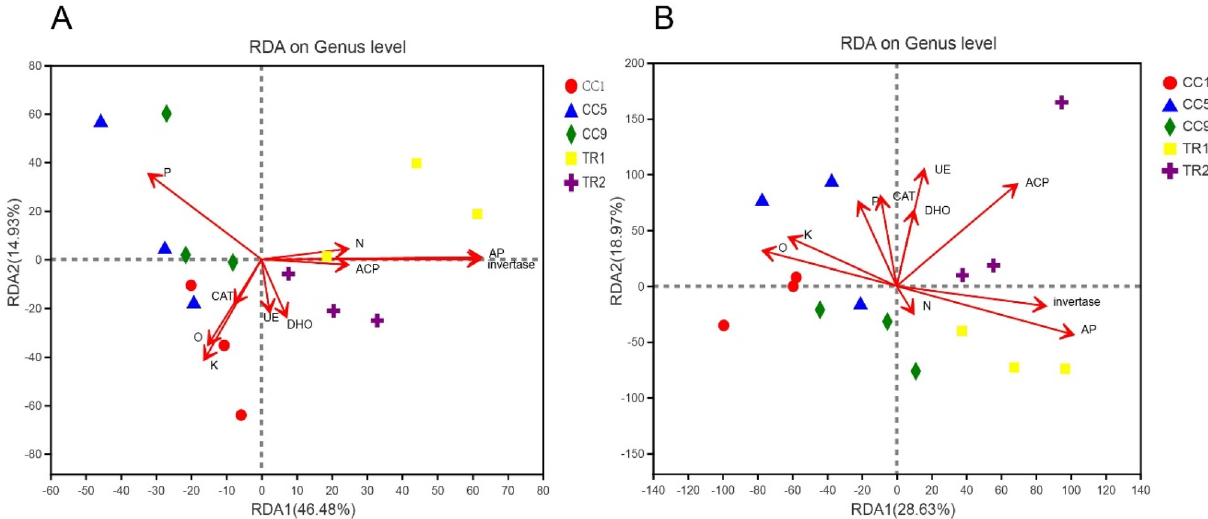
Figure 6. Compositions of pepper soil bacterial ( A ) and fungal ( B ) communities, and analyses of soil physical and chemical characteristics and enzyme activities using Redundancy Analysis (RDA), which can reflect the samples and environmental factors on the same two-dimensional ranking graph, so as to intuitively see the relationship between sample distribution and environmental factors). The RDA mapping data came from soil samples of the five continuous pepper cropping systems. Different coloured points or shapes in the figures represent sample groups from different environments or conditions. Red arrows indicate quantitative environmental factors. The lengths of the arrows represent the interpreted degree of influence of the environmental factors on species data. The included angles between environmental factor arrows represent positive and negative correlations (acute angle, positive correlation; obtuse angle, negative correlation; right angle, no correlation). The distance from the projection point to the origin represents the relative influence of environmental factors on the sample community distribution. P available phosphorus, K available potassium, TN total nitrogen, O organic matter, UE urease, DHO dehydrogenase; invertase, AP acid phosphatase, CAT catalase, ACP acid